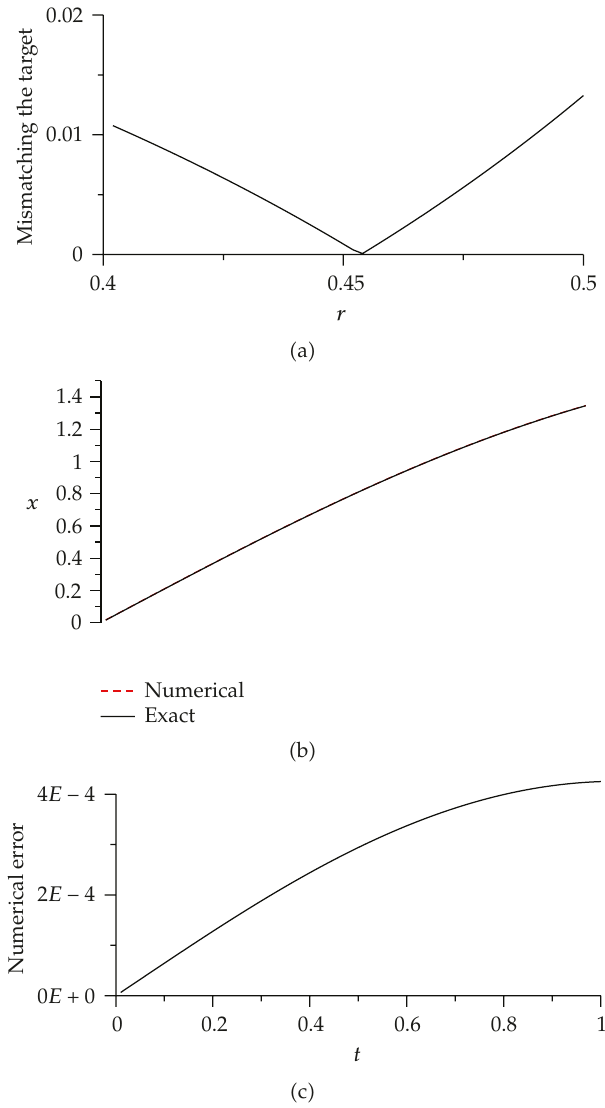
Figure 4: For example 3: (cid:3) a (cid:4) showing the error of mismatching, (cid:3) b (cid:4) comparing numerical and exact solutions, and (cid:3) c (cid:4) displaying the